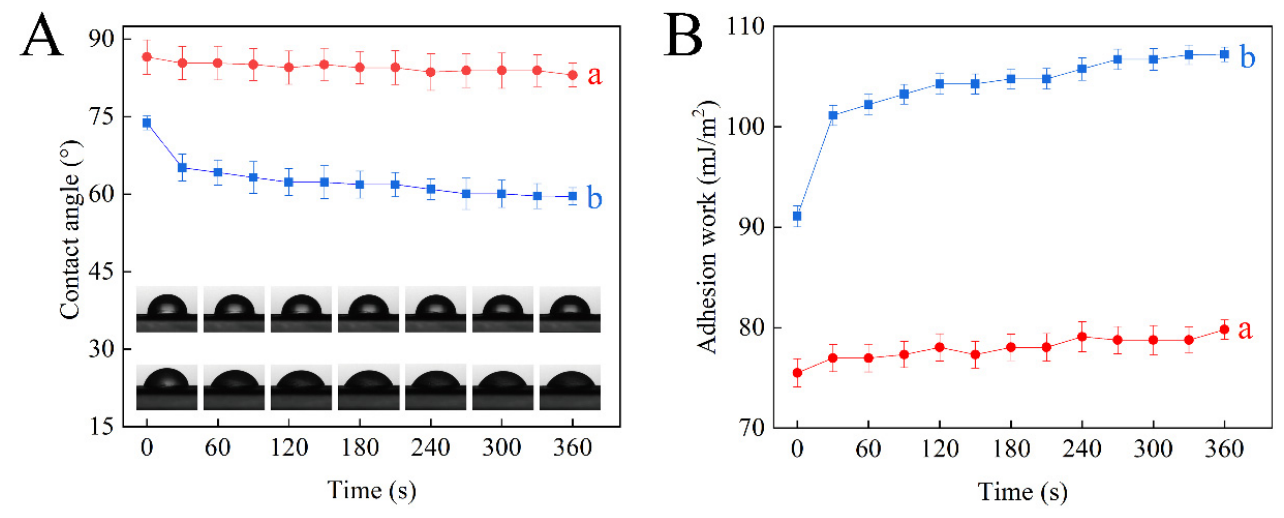
Figure 7. The CA ( A ) and AW ( B ) of Pro@HMS-NH 2 nanoparticles (a) and Pro@HMS-TA-Cu nanoparticles (b) on oilseed rape